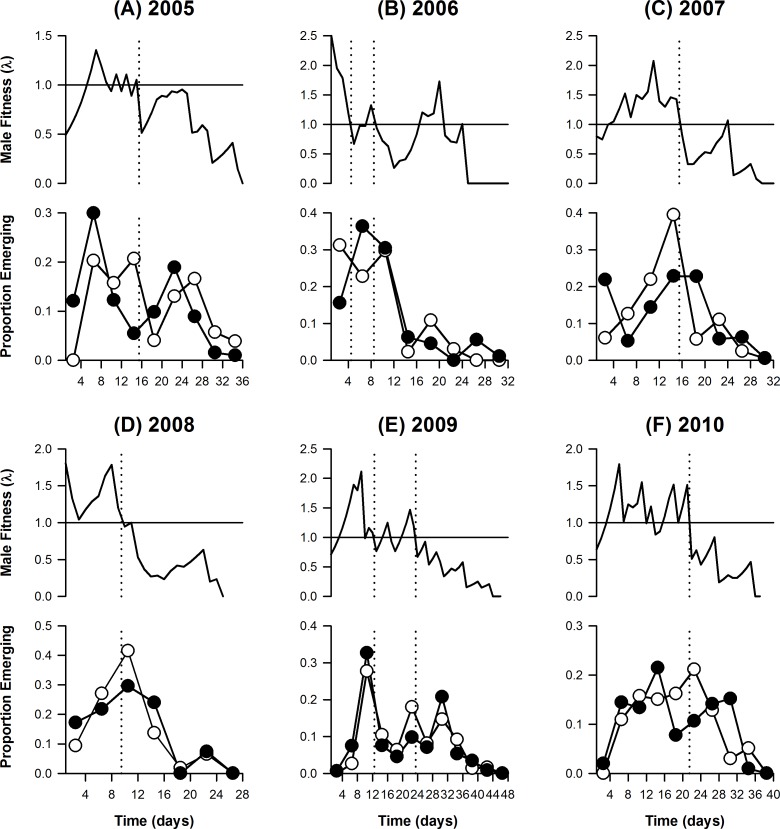
Predicted male fitness (A–C) in relation to male and female emergence curves (D–F) in the Dibbinsdale population for each year in the study period.The expected fitness (number of matings, λ) for males emerging on each day of the season was calculated from Eq. (2); a fitness of 1 is marked by the horizontal solid line. Male (filled circles) and female (open circles) daily emergences were estimated with POPAN and are summed over 4-day periods. Vertical dotted lines show the sub-division of each year into separate intra-seasonal periods based on long-term changes in predicted fitness (usually to a value <1; the peak in late season 2006 has been neglected since it only corresponds to a small number of specimens; high fitness periods in early season 2006 and 2009 have also been distinguished).